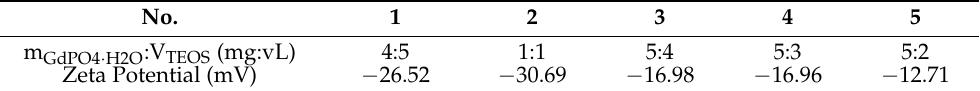
Table 1. Zeta potential of GdPO 4 ·H 2 O@SiO 2. No.